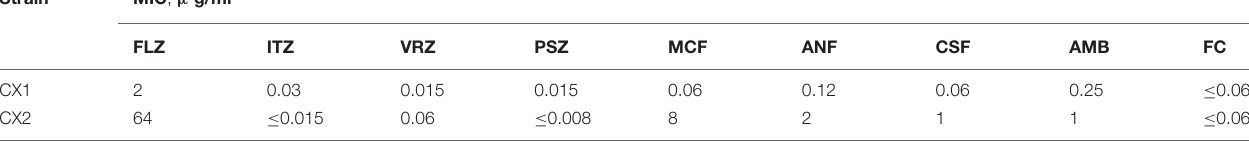
TABLE 1 | Antifungal